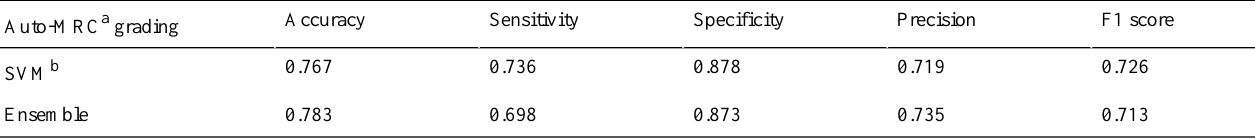
Table 4. Performance of auto-MRC